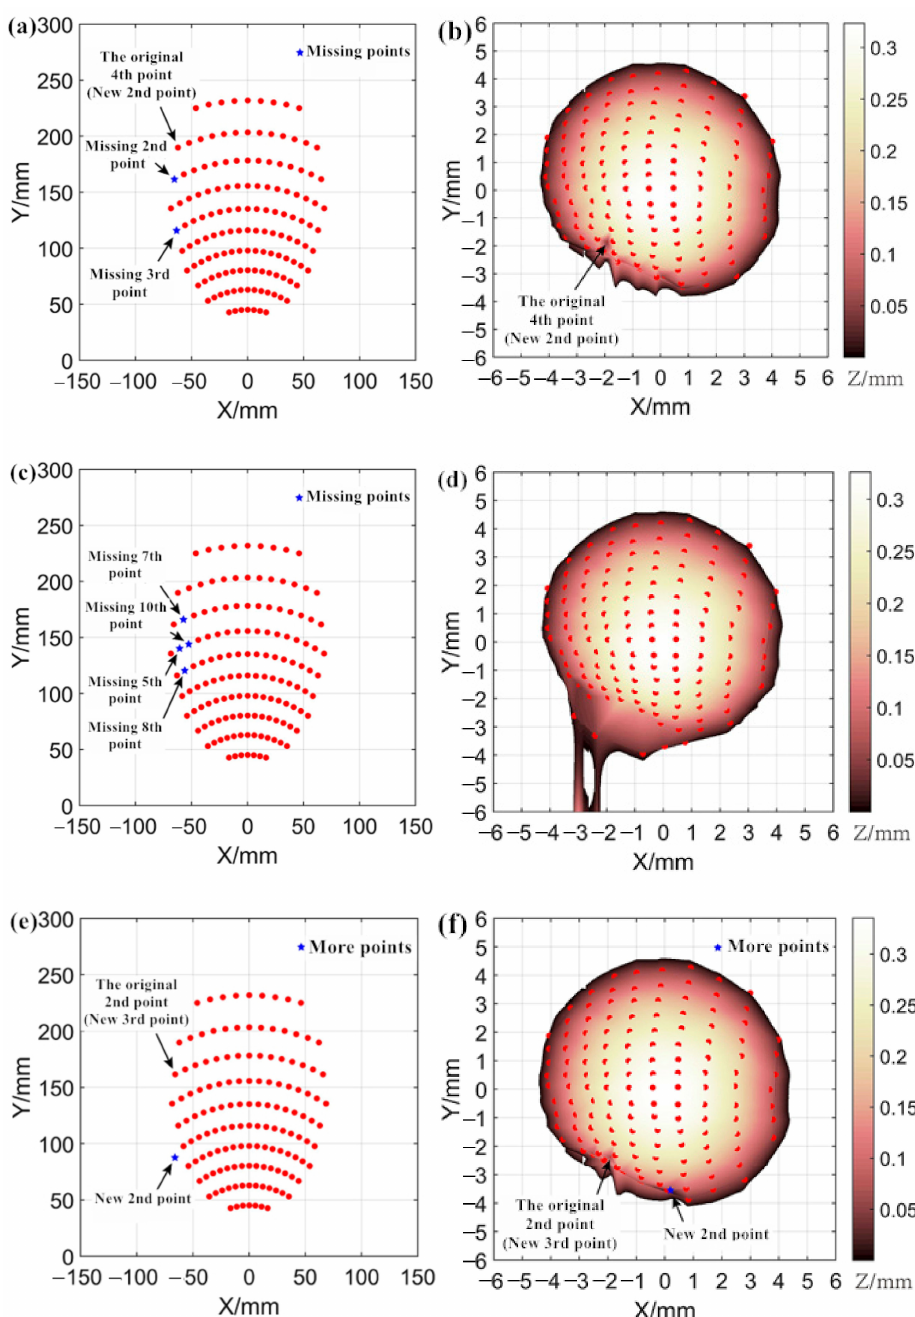
Figure 14. The reconstruction results of missing/adding the first few imaging points. ( a ) The reflection image of scattered missing points (missing the second and third points); ( b ) the reconstructed surface of ( a ); ( c ) the reflection image of concentrated missing points (loss four points); ( d ) the reconstructed surface of ( c ); ( e ) the reflection image of random adding points (original add a point); ( f ) the reconstructed surface ( e